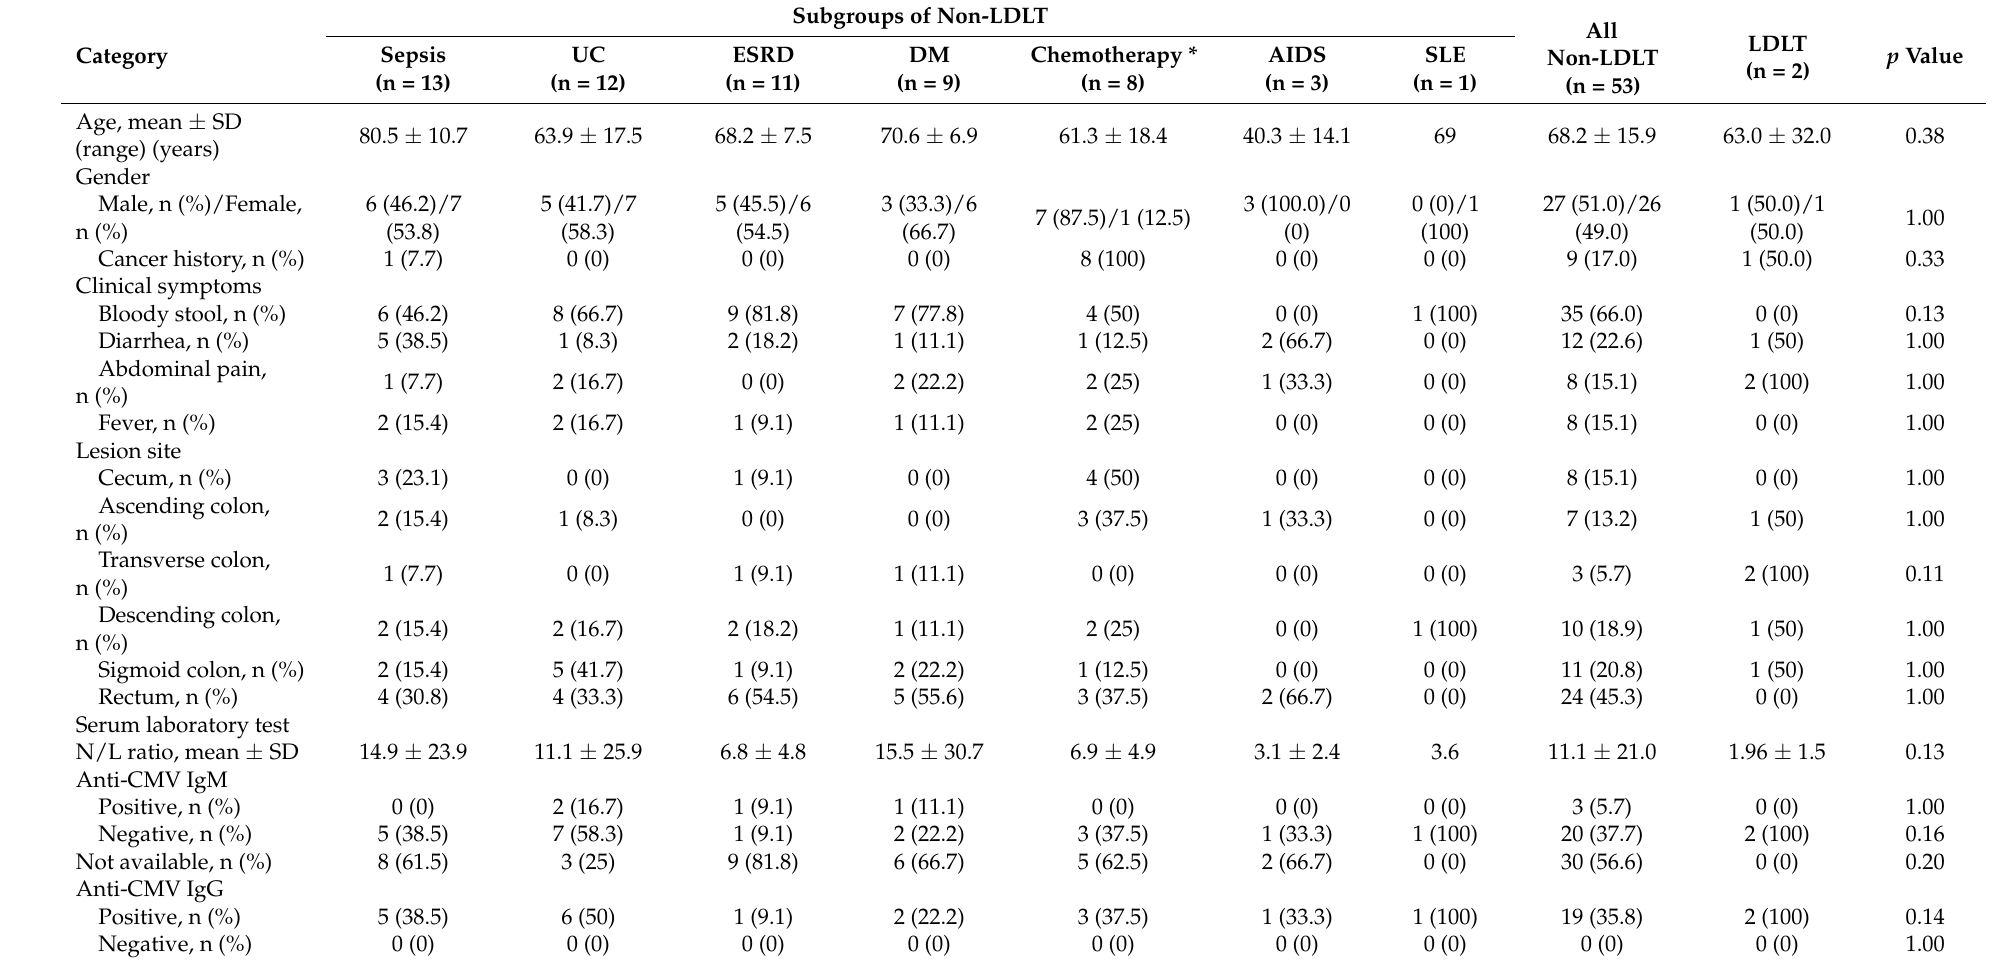
Table 3. Comparison of biopsy-proven CMV colitis patients with and without